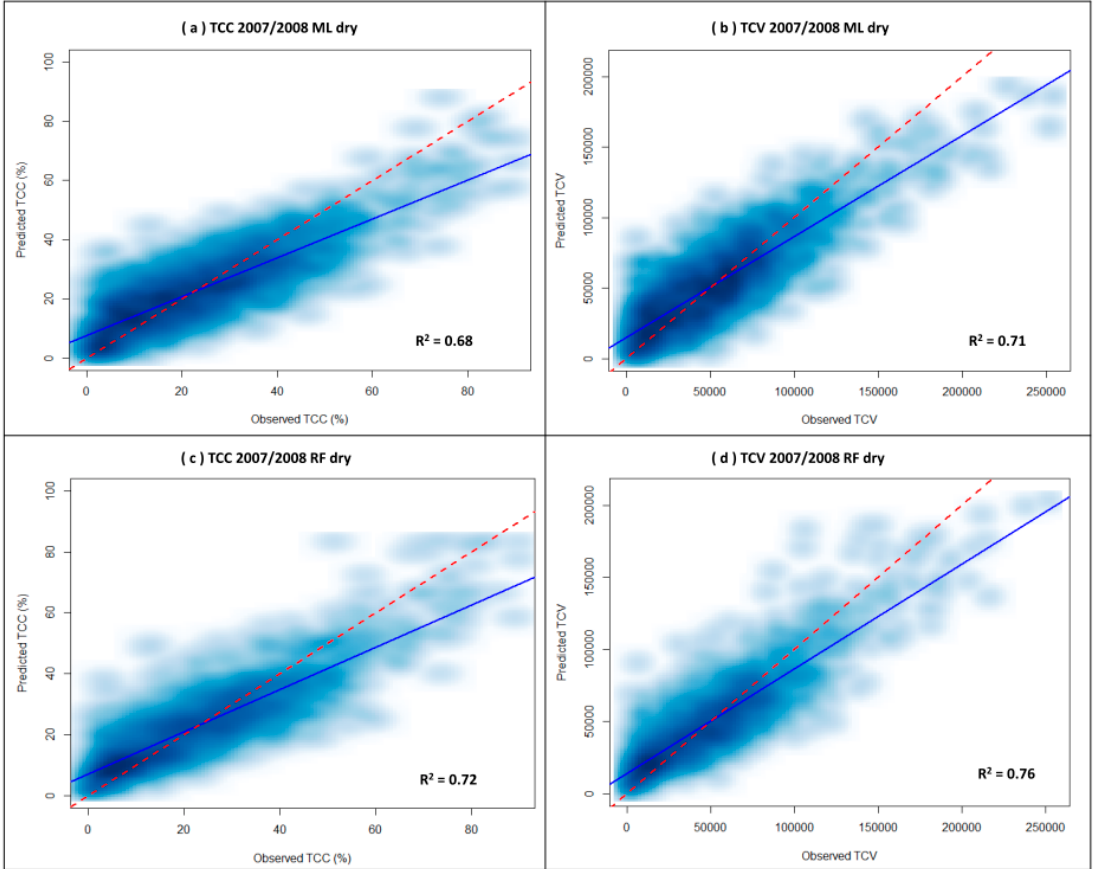
Figure 3. ( a – d ): Observed versus predicted scatterplots for the multi-linear regression (ML) and random forest (RF) 2007/2008 Dry scenario, both for the ( a , c ) TCC and ( b , d ) TCV metrics. The red dashed line represents the 1:1 line.